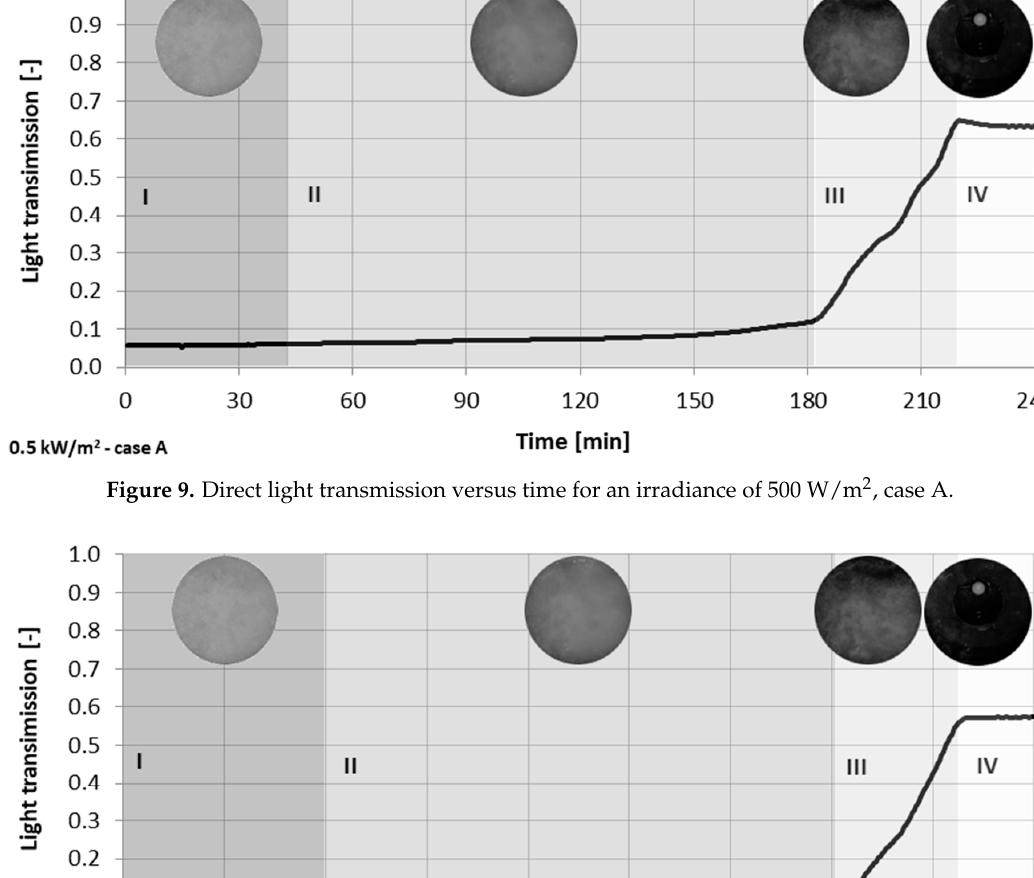
Figure 8. Direct light transmission versus time for an irradiance of 1000 W/m 2 , case B.